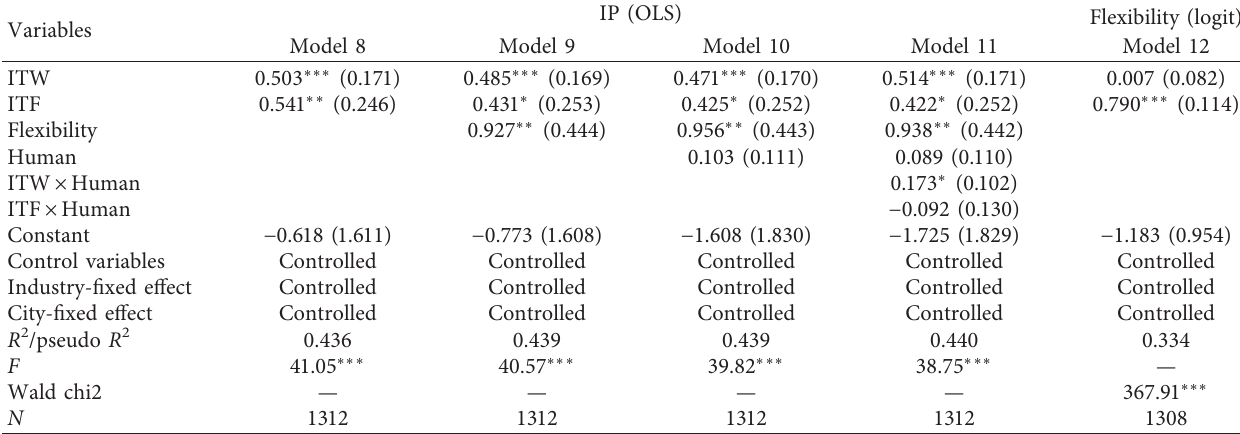
Table 3: Results of robustness